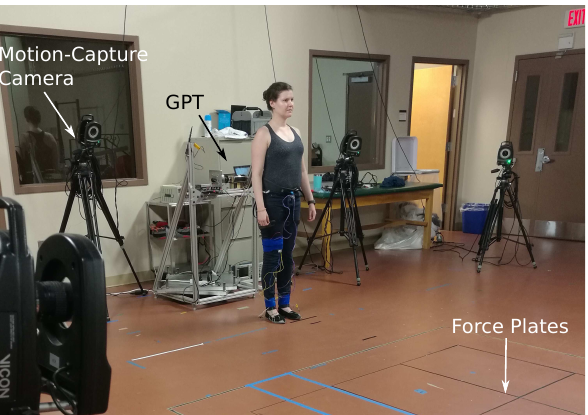
Figure 6. A user in front of the GPT ready to start training. She will walk over the in-ground force plates while feeling periodic resistance through the harness, and her kinematics will be recorded by the motion-capture system. The force plates are covered during actual training, so users do not adjust their step locations